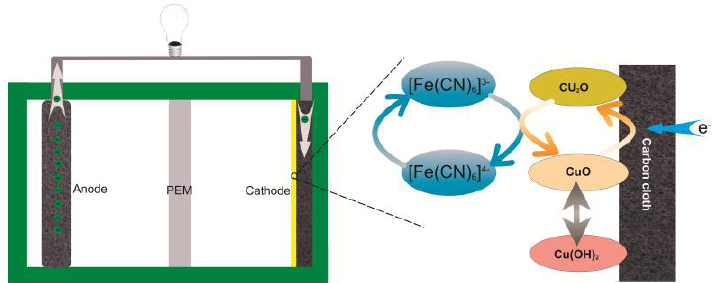
Figure 7. The mechanism of Cu oxide’s intermediation functions on the cathode in ferricyanide solution. The CuO on the cathode surface is first reduced to Cu 2 O by the electrons from the anode, and then Cu 2 O is oxidized to CuO by the ferricyanide. This redox cycle can accelerate the charge transfer rate on the cathode